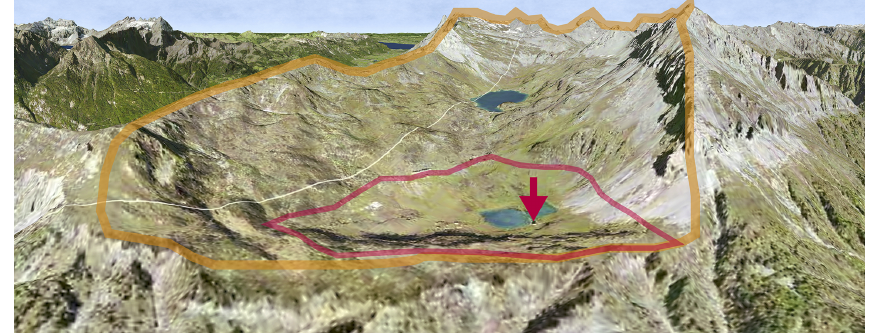
Figure 4. Oblique view of the surroundings of the Sorniot–LacInférieur de Fully weather station. The red arrow marks the location of the station, the red line marks the drainage area up to the lowest pass, and the orange line marks the full drainage area. The area was completely covered with snow and the lake was frozen during the eclipse. Imagery from Atlas of Switzerland V3 (Hurni, 2010), © 2016 swisstopo (JD100042).